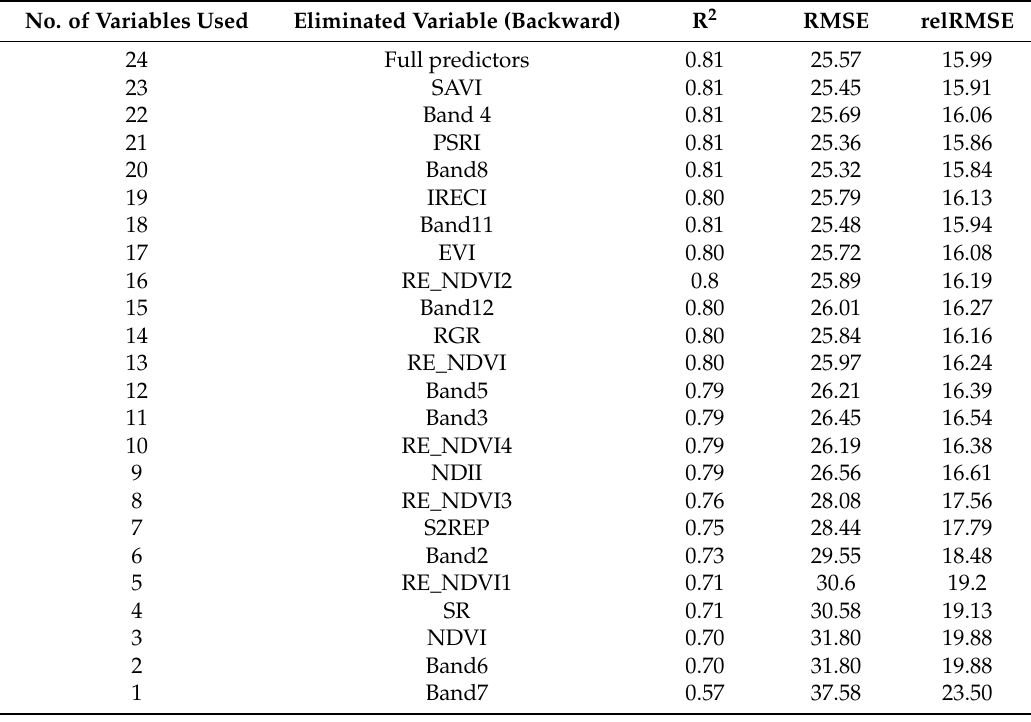
Table 3. Performance of models by backward elimination of variables from the RF